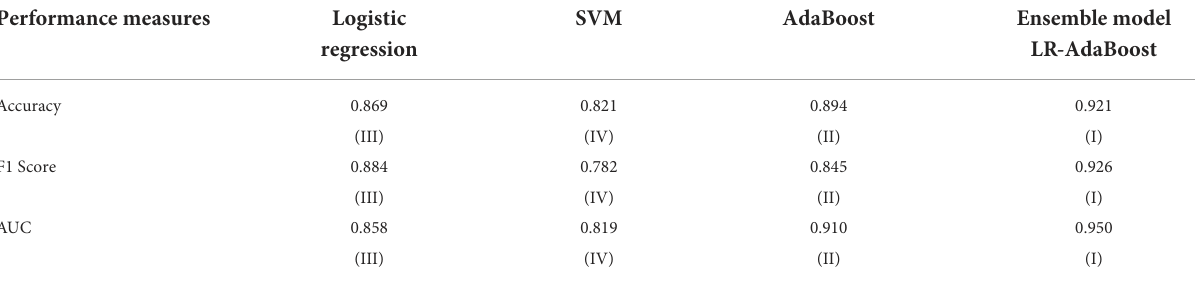
TABLE 3 Comparison of three performance metrics of different models using the MIT-BIH dataset. Performance